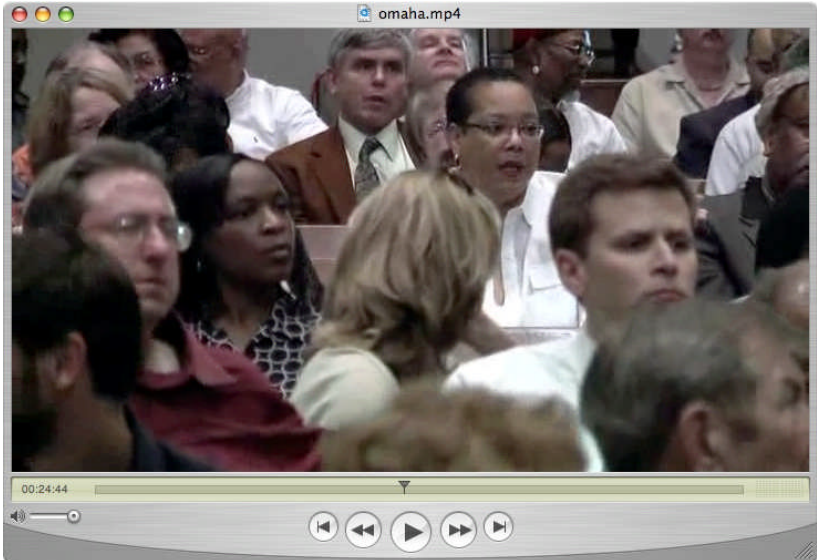
Figure 12: Re-visiting the Question Card sequence: A warning from an audience member [start 24:34 – end